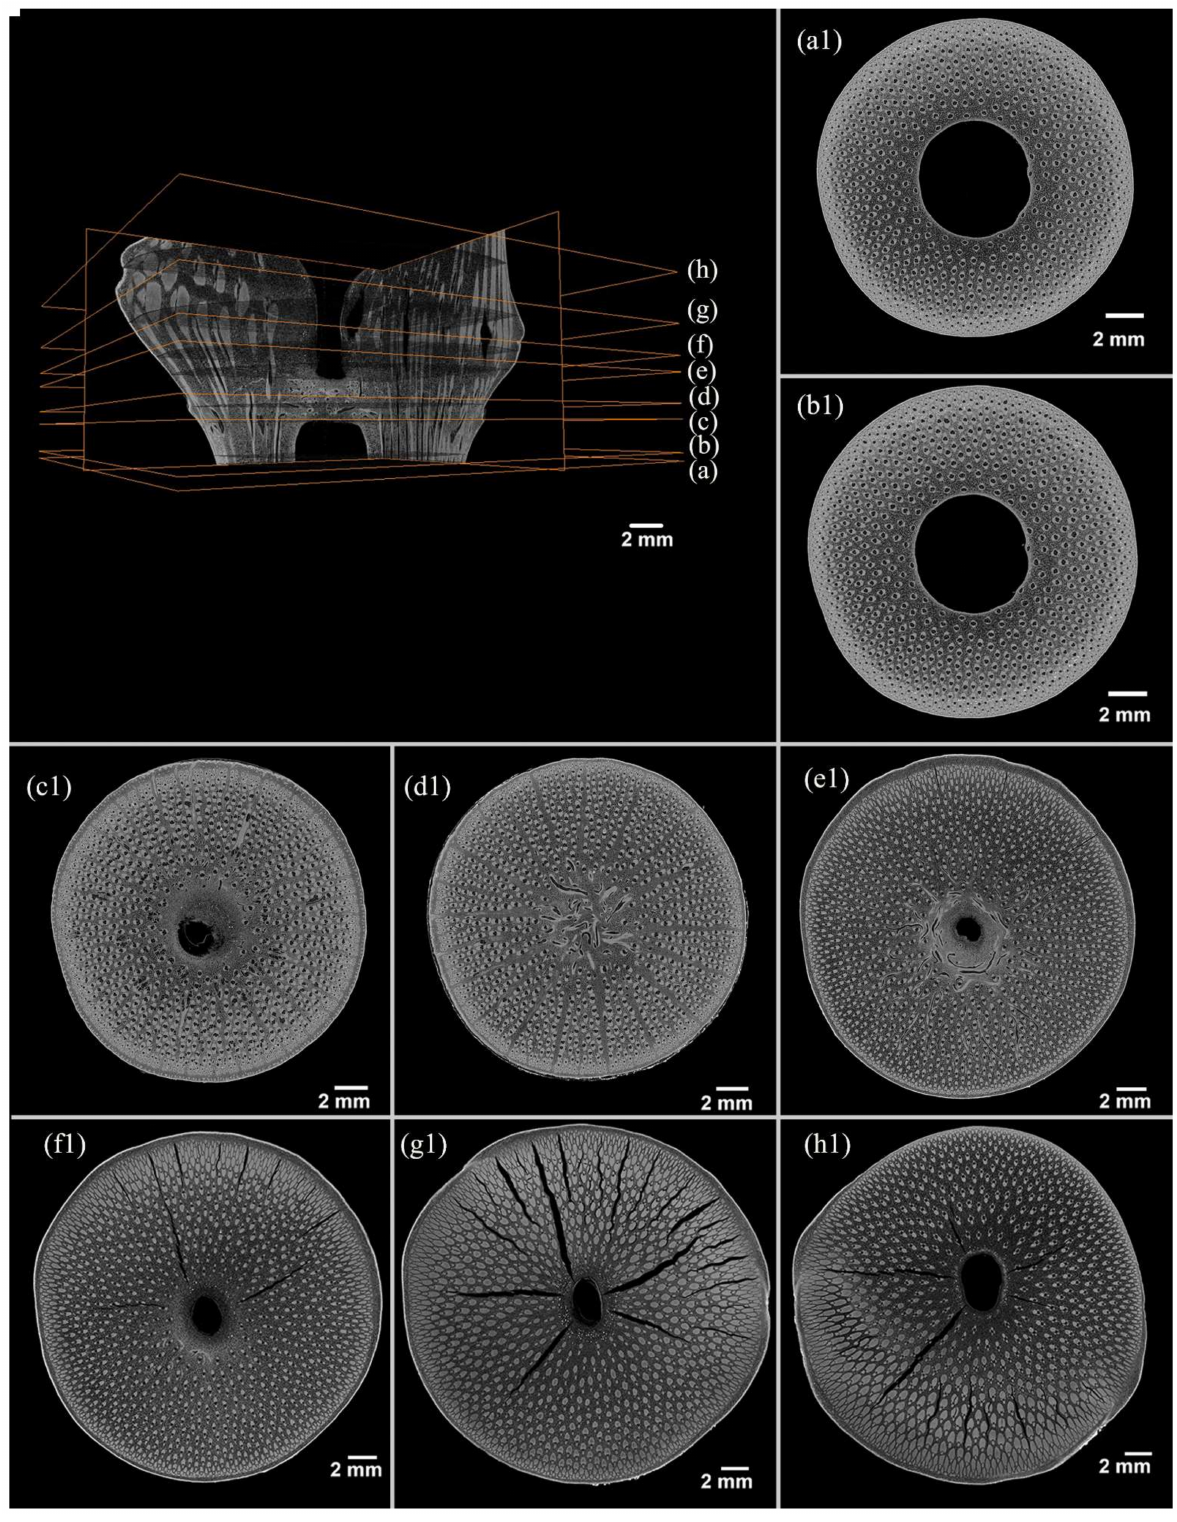
Figure 4. X-ray microtomography slices of the Q. tumidinoda node. The sequence number of the transversal slices is 329–1618 from the lower end to the upper end (details of a – h present in a1 – h1 ). ( a1 ) Slice 339, end of the node. ( b1 ) Slice 387, lower end of the node. ( c1 ) Slice 579, lower end of the sheath scar. ( d1 ) Slice 669, middle of the diaphragm. ( e1 ) Slice 849, upper end of the diaphragm. ( f1 ) Slice 944, lower end of the nodal ridge. ( g1 ) Slice 1129, middle of the nodal ridge, and ( h1 ) Slice 1429, upper end of the nodal